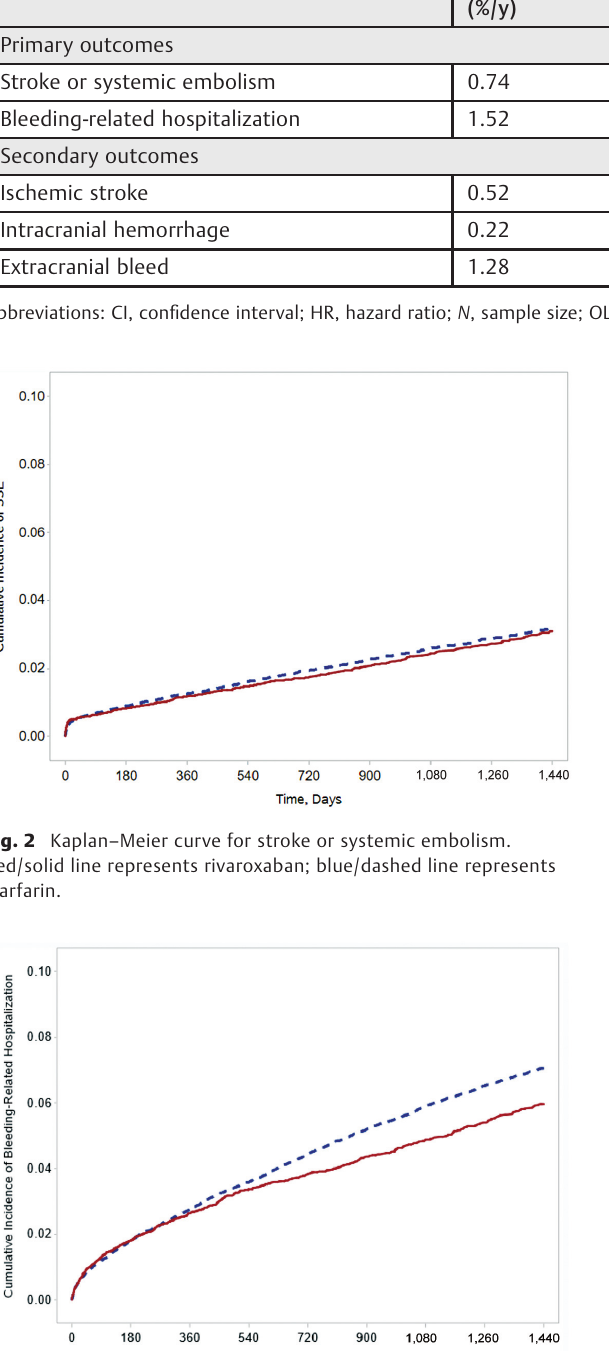
TH Open Vol. 7 No. 1/2023 © 2023. The